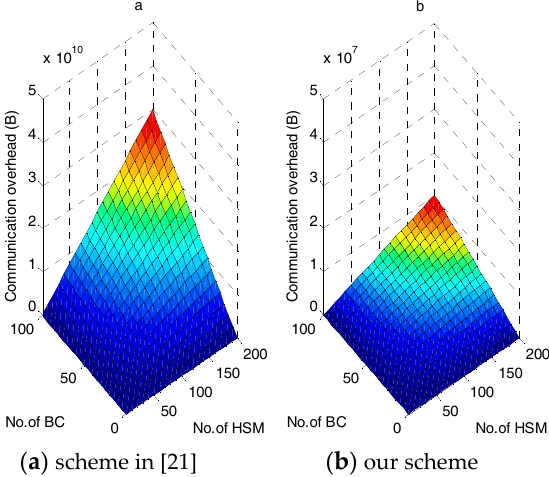
Figure 6. Total communication overhead in the power requirement stage.